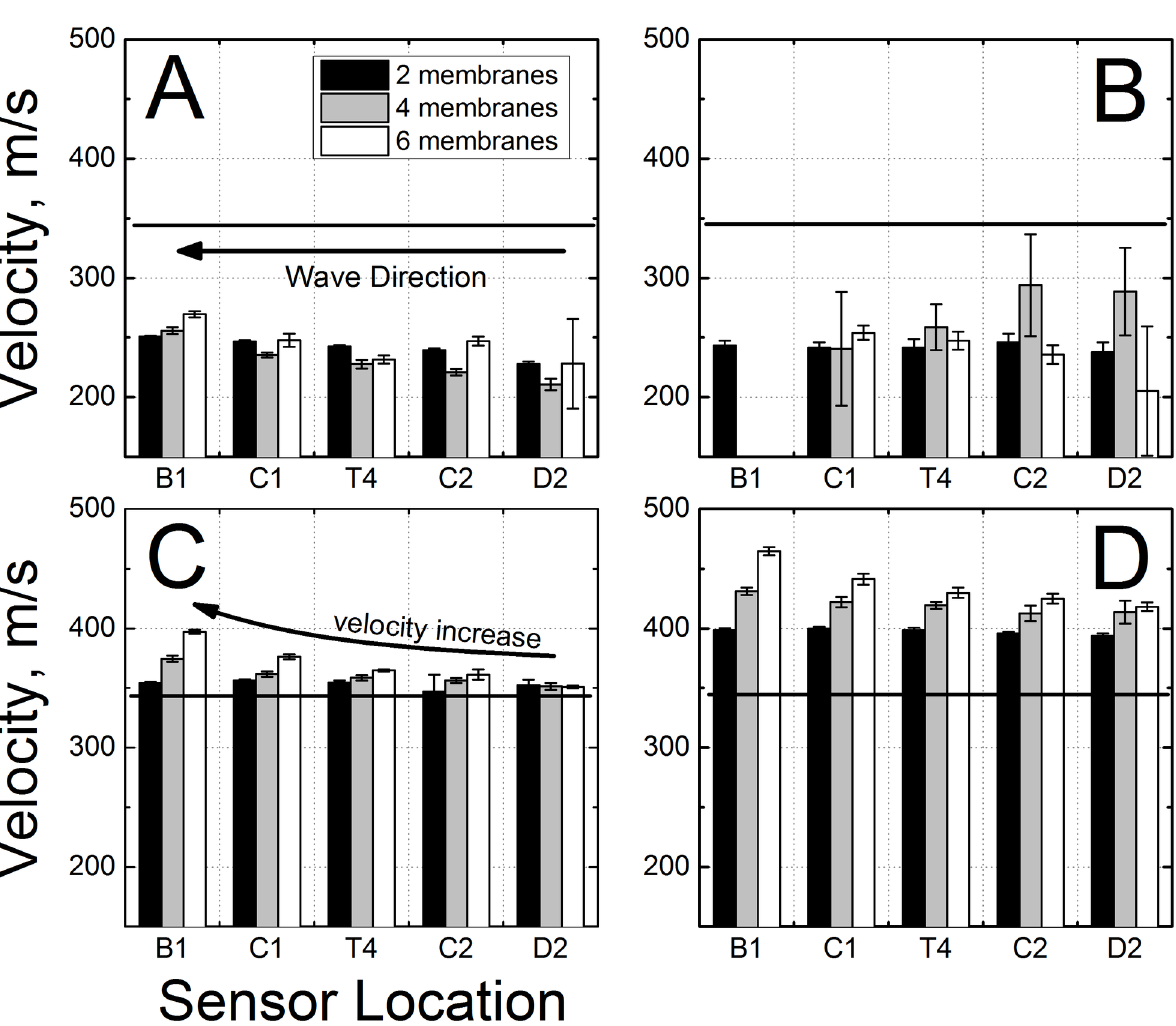
Fig 6. Velocities of reflected underpressure (A, B) and overpressure (C, D) waves generated with: A) open end, B) 4 ” gap, C) 2 ” gap and D) 0.625 ” gap. The straight arrow indicates the direction of the reflected waves ’ propagation. The red and green horizontal lines indicate sound speed in the air. The velocity of reflected waves increases with the distance from the end of the shock tube, which is caused by increased helium (driver gas) concentration closer to the breech. The D4 sensor was used as reference.